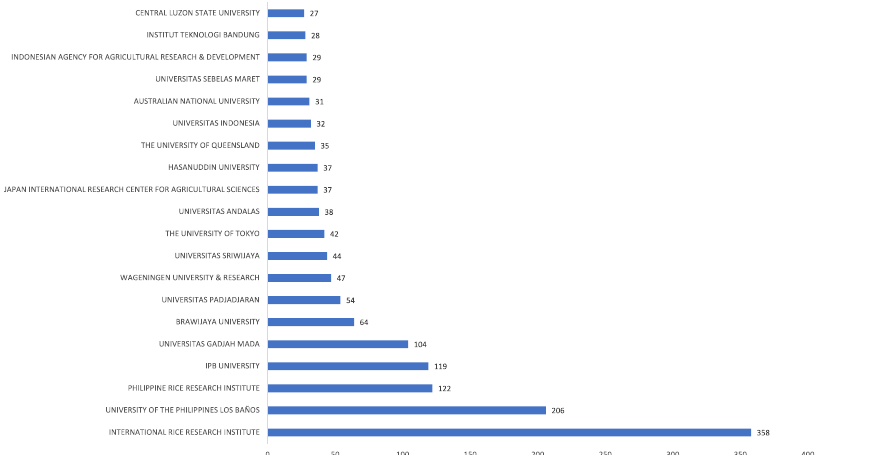
Fig. 5 Af fi liations of rice researchers in Indonesia and the Philippines, n = 20 af fi liations. The top 5 most productive institutions in terms of rice research in Indonesia and the Philippines are the IRRI, the University of the Philippines System, the PhilRice, the Institute Pertanian Bogor/IPB University, and the University of Gadja Mada.